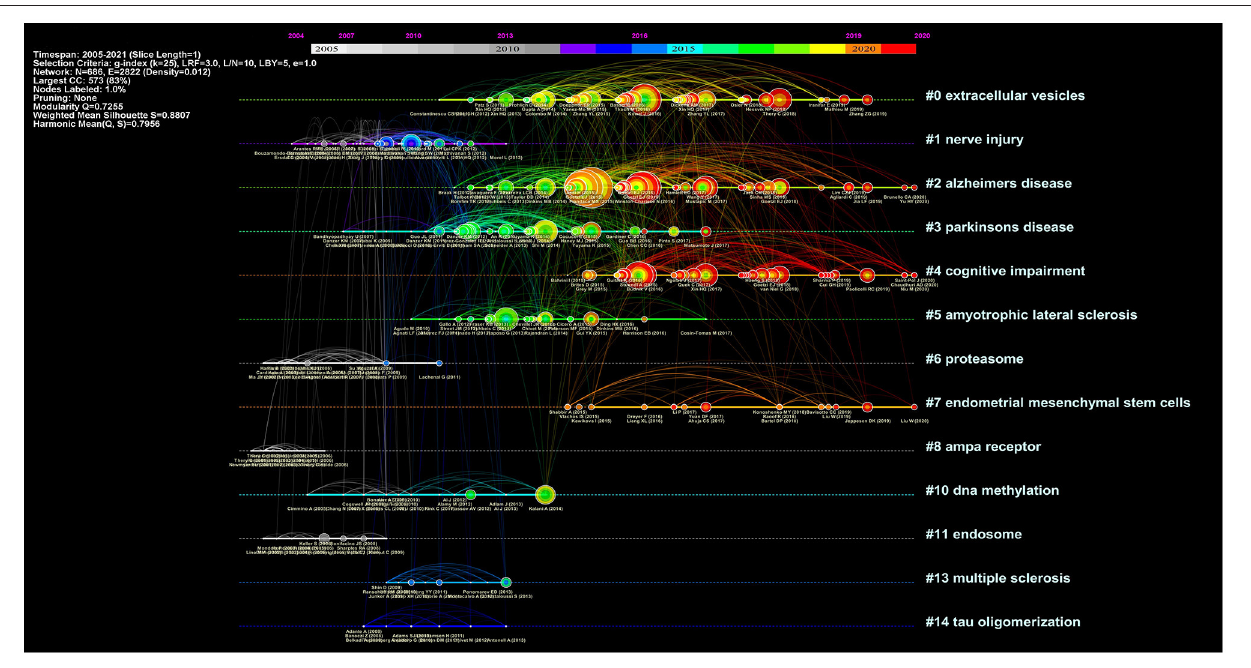
FIGURE 10 | A timeline view of co-citation network about exosomes in the field of neuroscience.